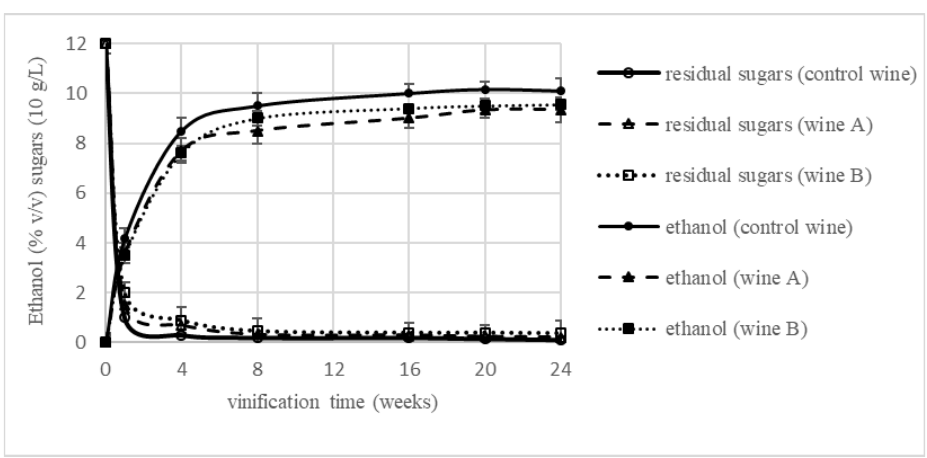
Figure 2. Sugar consumption and ethanol production during vinification of cherry wine with green tea addition.